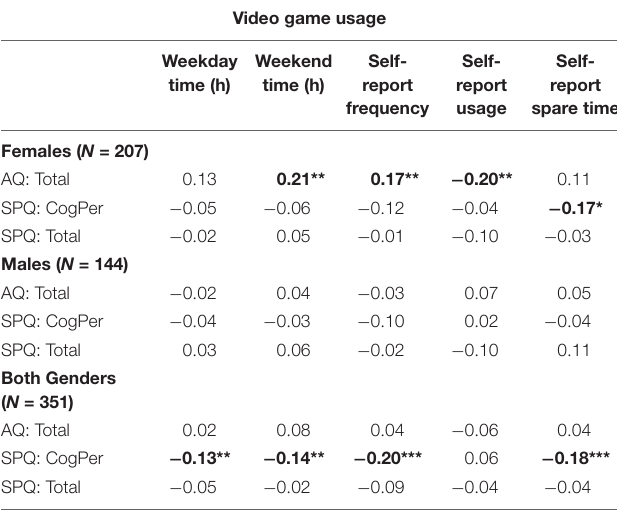
TABLE 1 | Pearson Correlations of AQ-total, SPQ-total, and SPQ-CogPer scores with Measures of Video Game